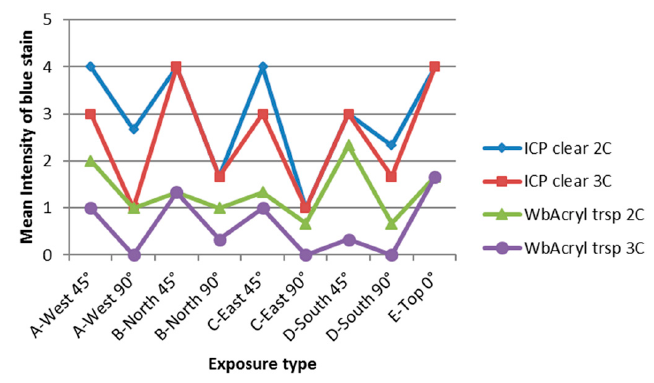
Figure 10. Mean intensity of blue stain after nine months of exposure (May 2016) using the MFER.